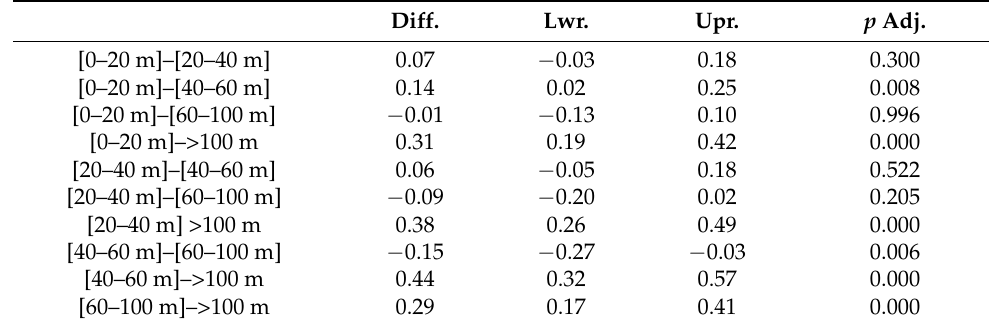
Table 2. Tuckey post hoc test for the differences between larval abundances, per strata ( p < 0.05). Diff. Lwr. Upr. p Adj.